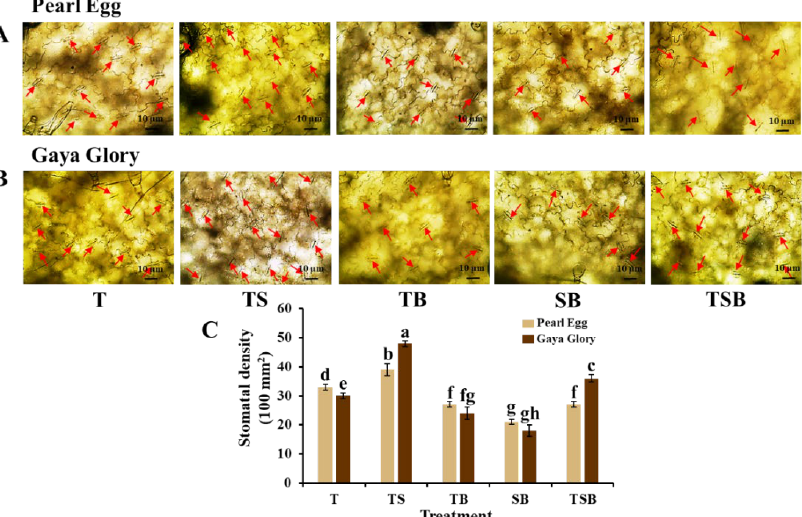
Figure 5. Changes in the stomatal density of chrysanthemum ‘Pearl Egg’ and ‘Gaya Glory’ plants as affected by the different lighting direction combinations. Micrographs of stomata (20 ×) ( A , B ) and stomatal density ( C ) of “Pearl Egg” and “Gaya Glory” as affected by the different lighting direction combinations after 45 days of cultivation. The red arrows indicate the stomata. T, TS, TB, SB, and TSB, refer top (1/1), top (1/2) + side (1/2), top (1/2) + bottom (1/2), side (1/2) + bottom (1/2), and top (1/3) + side (1/3) + bottom (1/3) lighting, respectively. Vertical bars indicate the means ± standard error ( n = 6). Different lowercase letters indicate significant separations within treatments by Duncan’s multiple range test at p ≤ 0.05. Bars indicate 10 µ m.